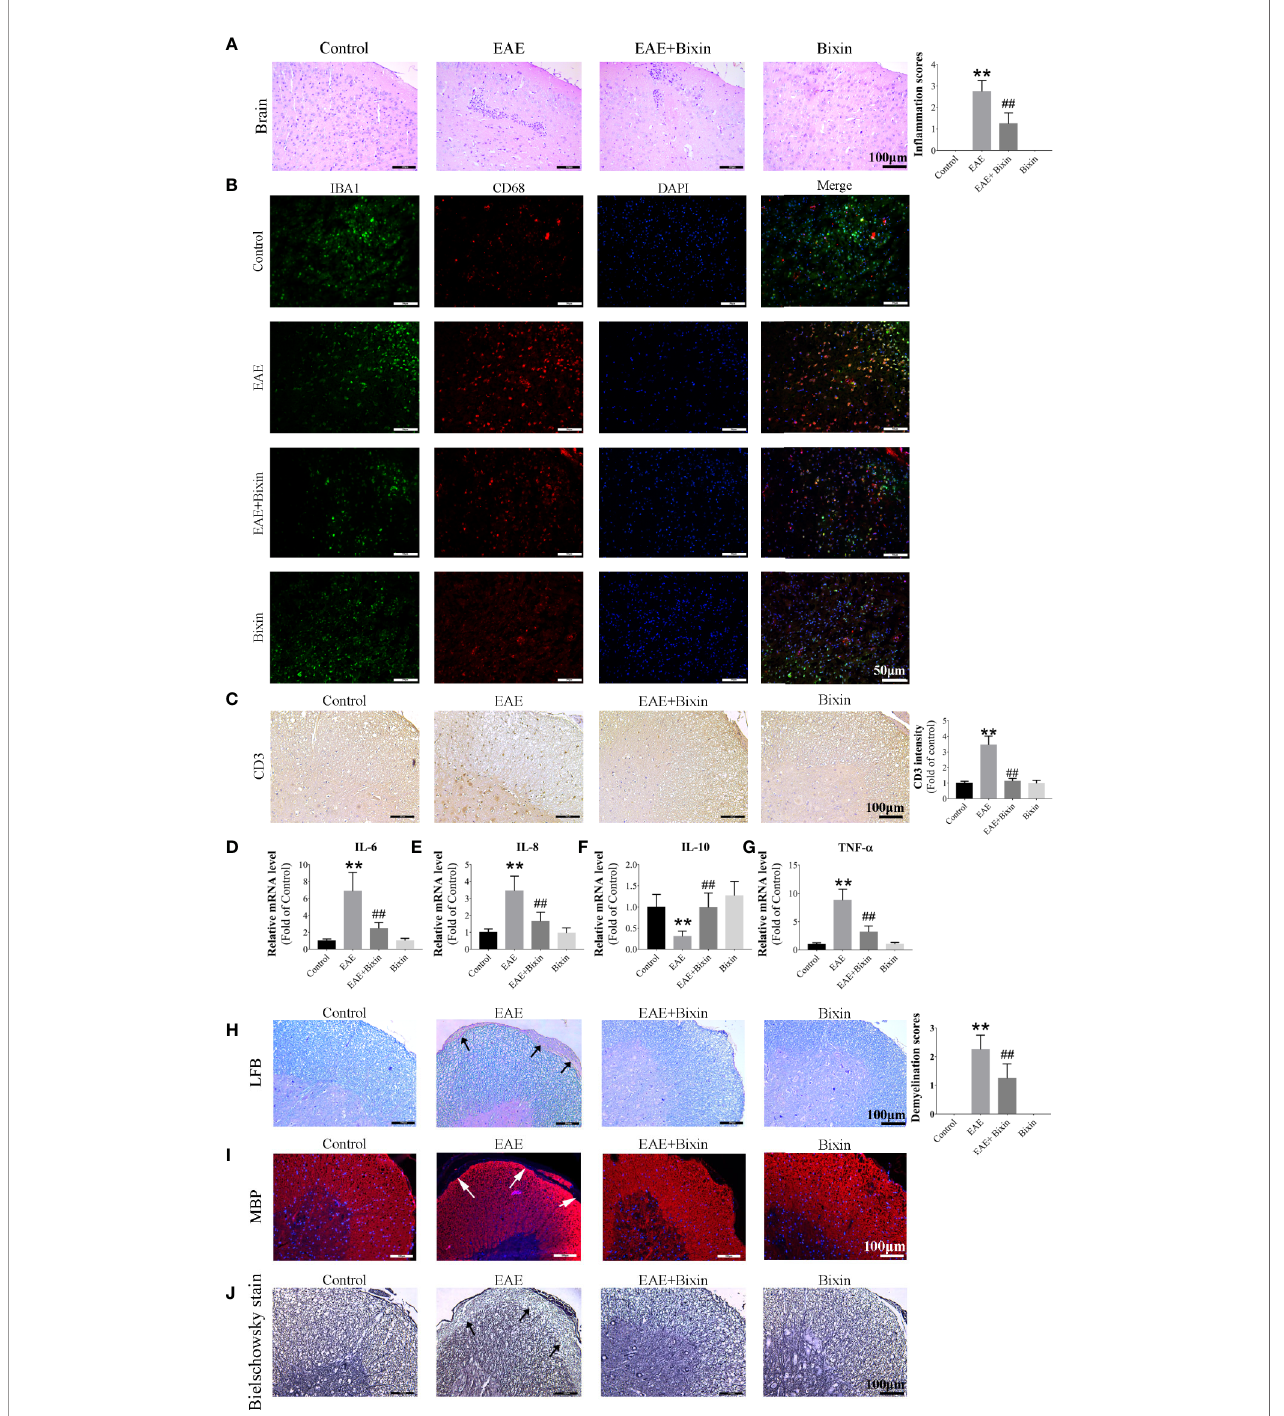
FIGURE 2 | Bixin reduces the in fl ammation and demyelination in EAE mice (A) . H&E staining showing in fl ammatory cell in fi ltration in the brain, as well as the in fl ammation scores. Scale bars: 100 m m (B) . Representative IF images of IBA1 and CD68 in brain sections showing the activated microglia. Scale bars: 50 m m (C) . Representative IHC images of CD3+ cells in the spinal cord. Scale bars: 100 m m (D – G) . mRNA expression of the in fl ammatory cytokines IL-6, IL-8, IL-10, and TNF- a were quantitated by qRT-PCR (H) . LFB staining showing demyelination in the spinal cord, as well as the demyelination scores. Scale bars: 100 m m (I) . IF staining of MBP in the spinal cords. Scale bars: 100 m m (J) . Bielschowsky staining showing the degree of axon degeneration. Scale bars: 100 m m. Data shown in graphs represents the means ± SD (n = 5). **P < 0.01, vs. control group; ## P < 0.01, vs. EAE